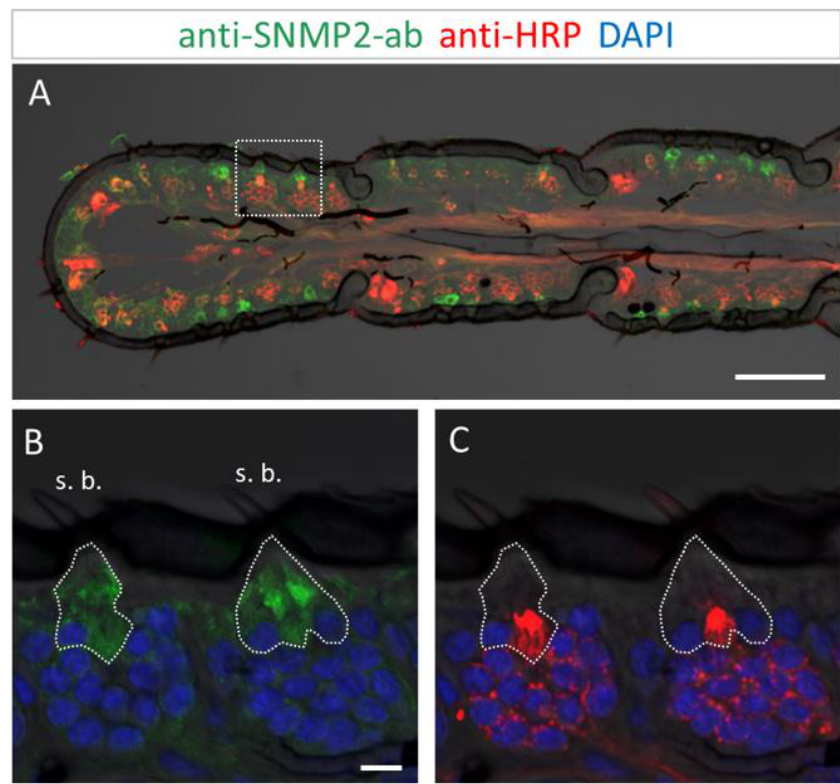
Figure 5. SNMP2 expression in cells of the S. gregaria antenna. SNMP2-positive cells were visualized by FIHC in the longitudinal section using anti-SNMP2-ab (green). Neurons were visualized by anti- HRP-antibody (red) and nuclei by staining with DAPI (blue). ( A ) Topography of SNMP2-expressing cells in multiple antennal segments. ( B , C ) Displays the area boxed in ( A ) in a higher magnification and different channel. ( B ) Shows the green and blue channels, demonstrating the expression of SNMP2 in support cells (encircled) underneath basiconic sensilla (s. b.). ( C ) Shows the red and blue channels, displaying the clusters of OSNs housed in the basiconic sensilla. Neuronal labelling within the encircled area corresponds to the dendrites of OSNs passing by support cells on the way to the hair shaft. In all images, the fluorescent channels were overlaid with the transmitted light channel. Scale bars: ( A ) = 100 µ M; ( B ) = 10 µ